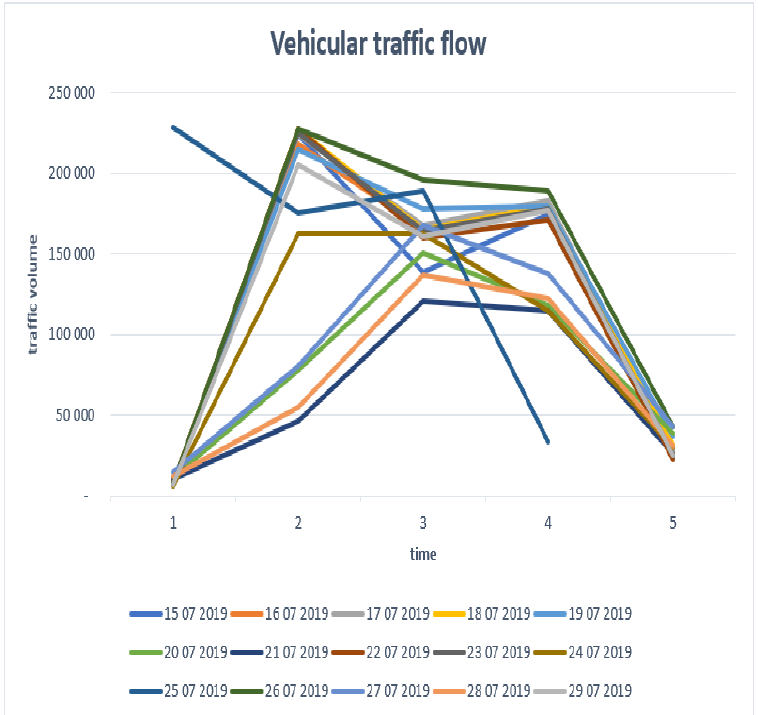
Figure 12. Road intersection 4.